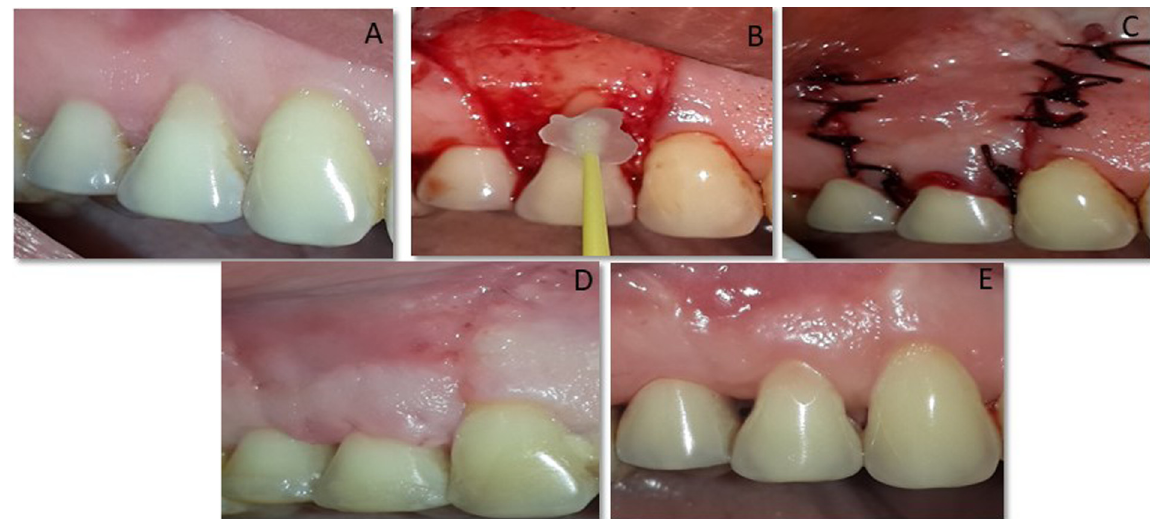
Fig. 4. Pre-surgical, surgical and post-surgical recipient site treated by CAF +HYALOSS, for Test Group, Case 4. (A) Pre-operative gingival recession defect with 14. (B) Hyaloss applied at recipient site. (C) Coronally advanced fl ap sutured over Hyaloss. (D) Post-operative view at 15 days. (E) Post-operative view at 90